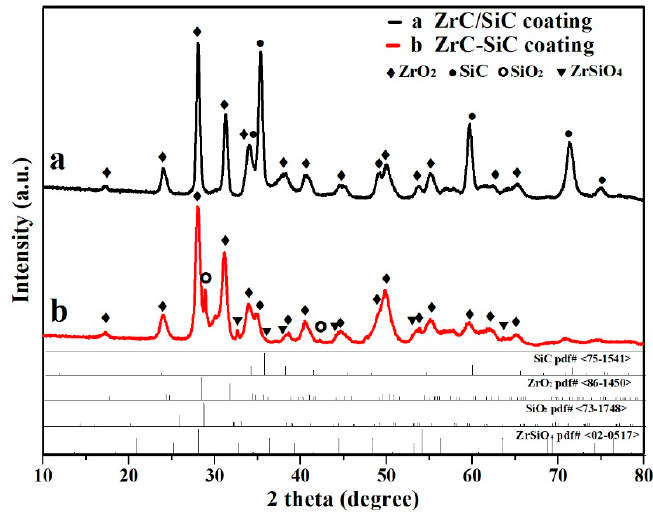
Figure 5. The XRD patterns of ZrC/SiC and ZrC-SiC coatings after ablation.